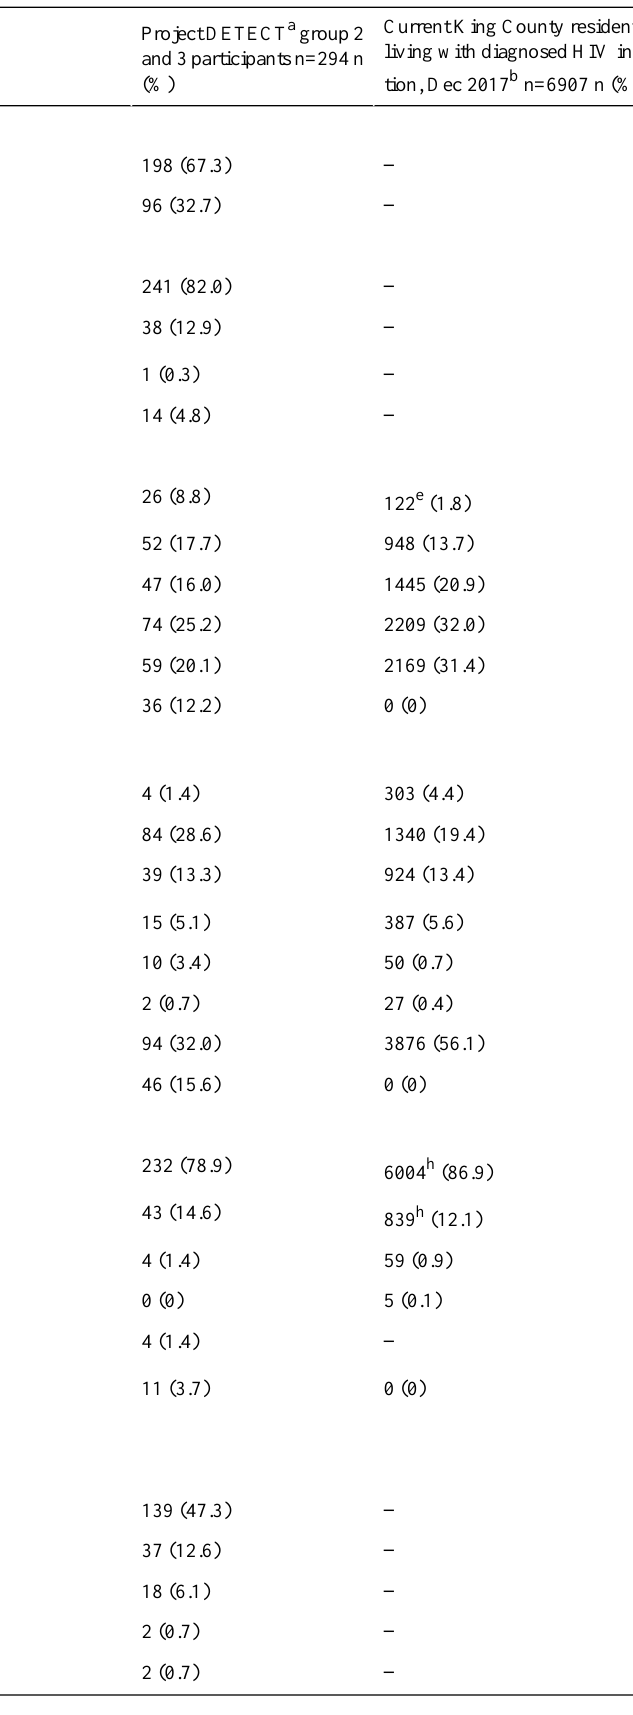
Table 3. Characteristics of Project DETECT part 2–group 2 and group 3 participants (September 2015 to March 2019) compared with current King County residents living with diagnosed HIV infection as of December 31,